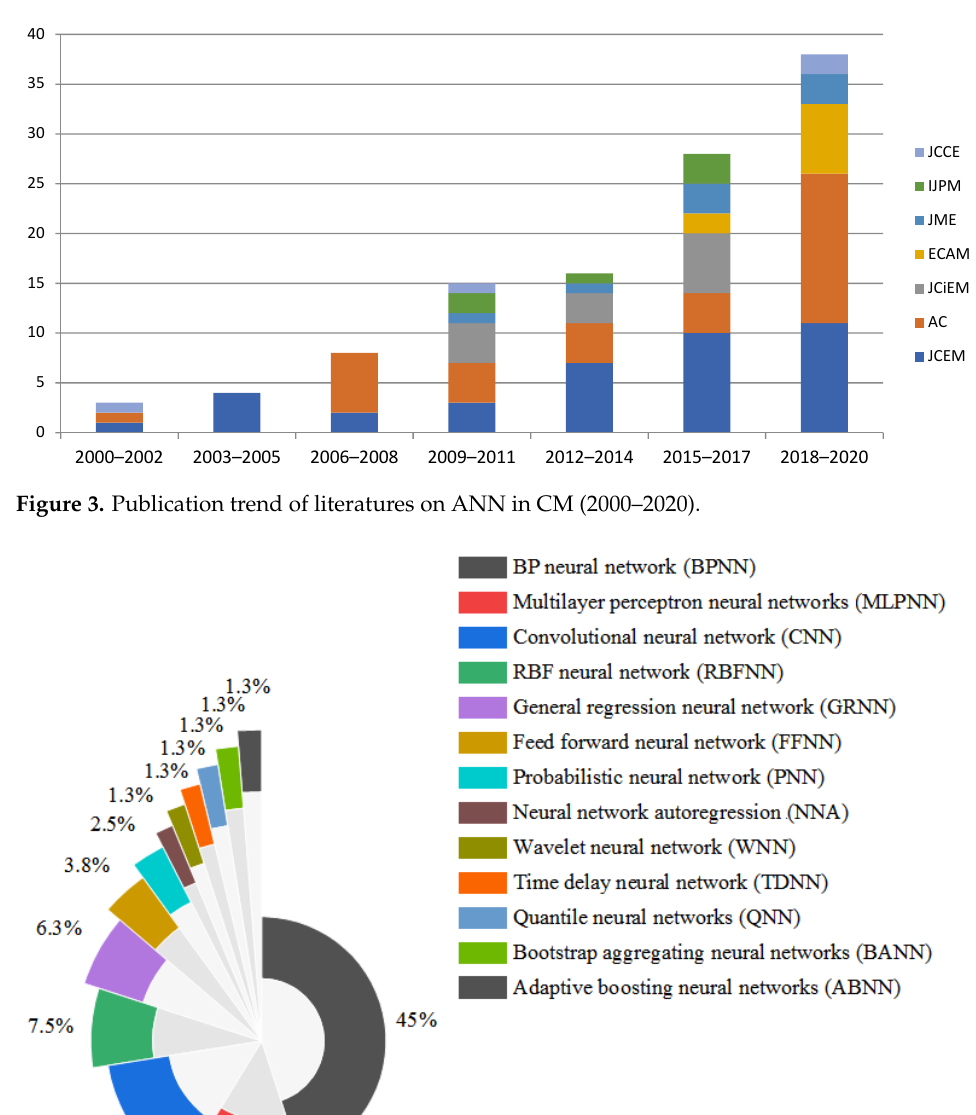
Figure 3. Publication trend of literatures on ANN in CM (2000–2020).